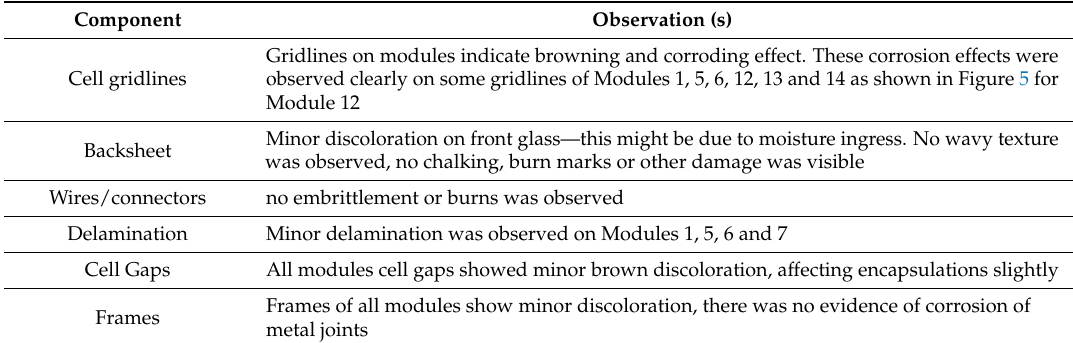
Table 2. Summary of results of visual